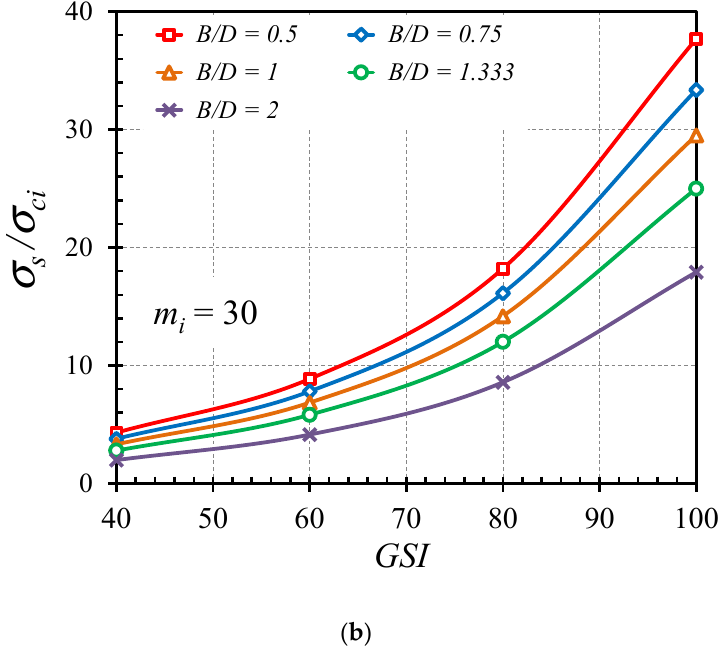
Figure 4. Impact of GSI on σ s / σ ci of horseshoe tunnels with C / D = 3 and σ ci / γ D = 1000: ( a ) m i = 5 and ( b ) m i = 30.